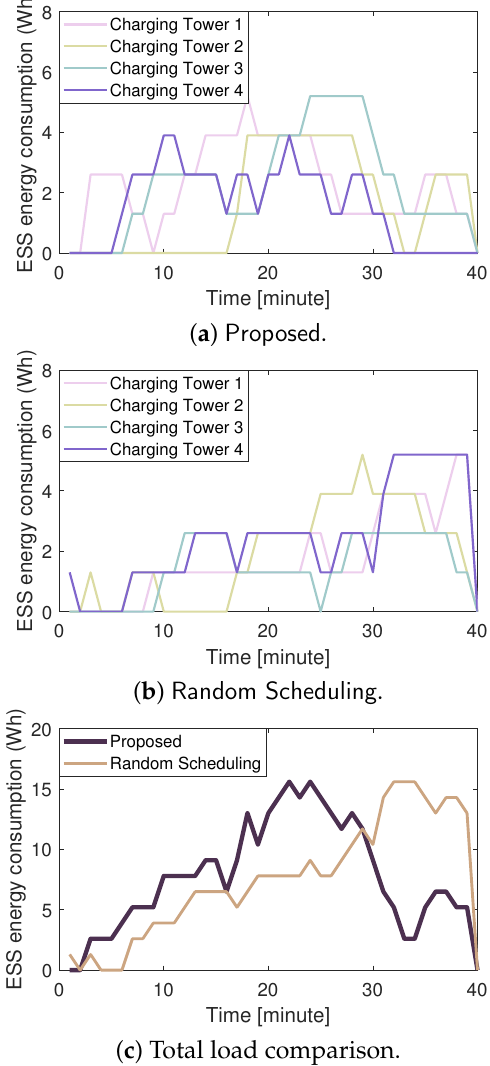
Figure 4. Energy consumption (load) in each charging tower with ( a ) the Proposed algorithm, ( b ) the Random Scheduling algorithm, and ( c ) comparison of the total amount between the Proposed algorithm and the Random Scheduling